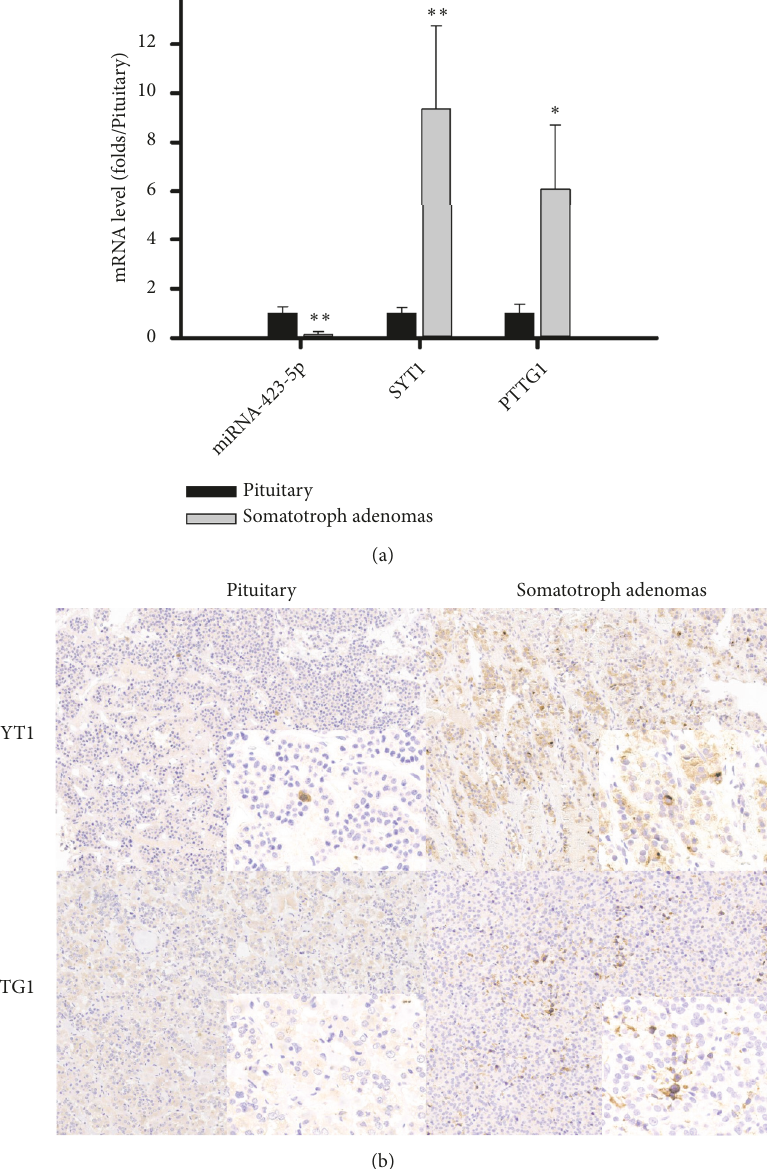
Figure 3: Levels of miR-423-5ptarget genes PTTG1 and SYT1 in pituitary and somatotroph adenomas. (a): MRNA levels for PTTG1 and SYT1 in pituitary and somatotroph adenomas. ∗ p < 0.05, ∗∗ p < 0.01 (b): IHC of PTTG1 and